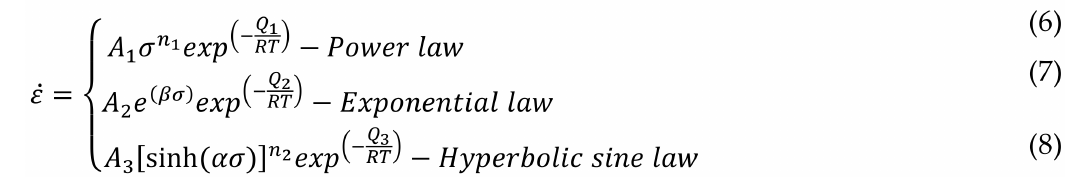
Figure 2 . The plots of ln(cid:2013)(cid:4662) − ln(cid:2026) ( a ); ln(cid:2013)(cid:4662) − (cid:2026) ( b ); plots of ln(cid:2013)(cid:4662) − lnsinh((cid:2009)(cid:2026)) ( c ); and lnsinh((cid:2009)(cid:2026)) − Figure 2. The plots of ln (cid:2869)(cid:2868)(cid:2868)(cid:2868) ( d ). (cid:3019)(cid:3021)